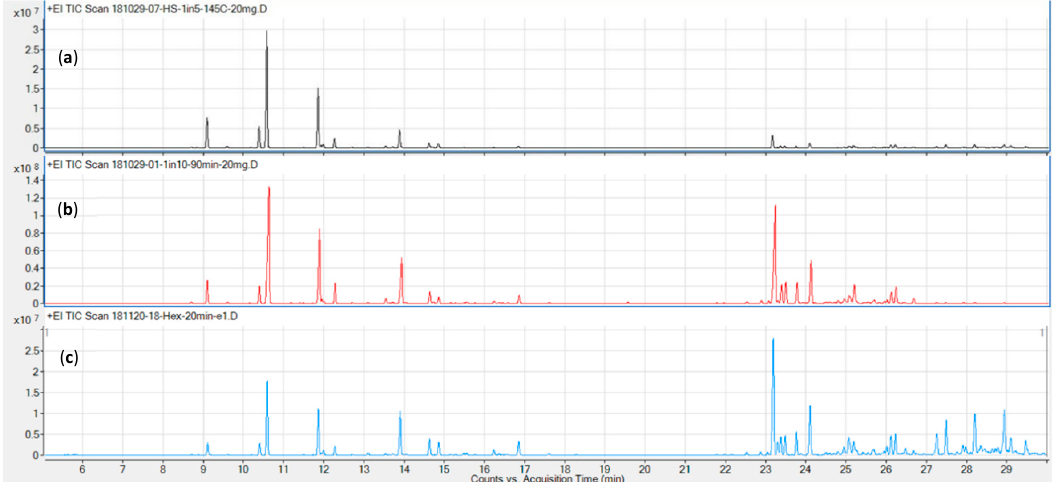
Figure 2. Representative chromatograms for the three columns tested: ( a ) DB17; ( b ) VF-35; ( c ) DB-5.